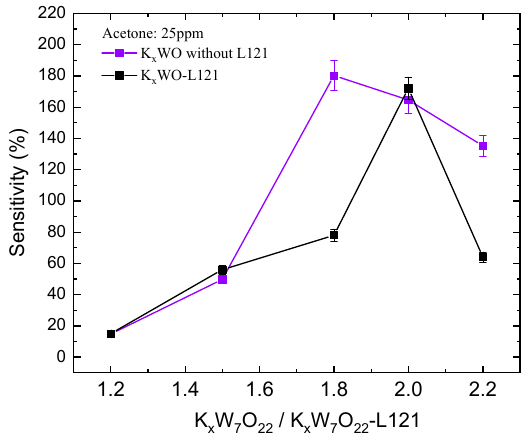
Figure 4. Sensing response to 25-ppm acetone using K x WO grown with and without L-121.